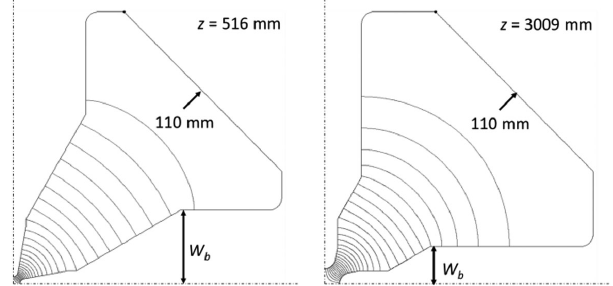
FIG. 2. Cross-sectional shapes of the cavity at z ¼ 516 (left) and 3009 mm (right) obtained with RFQFISH . The distance from the cavity center to the wall is 110